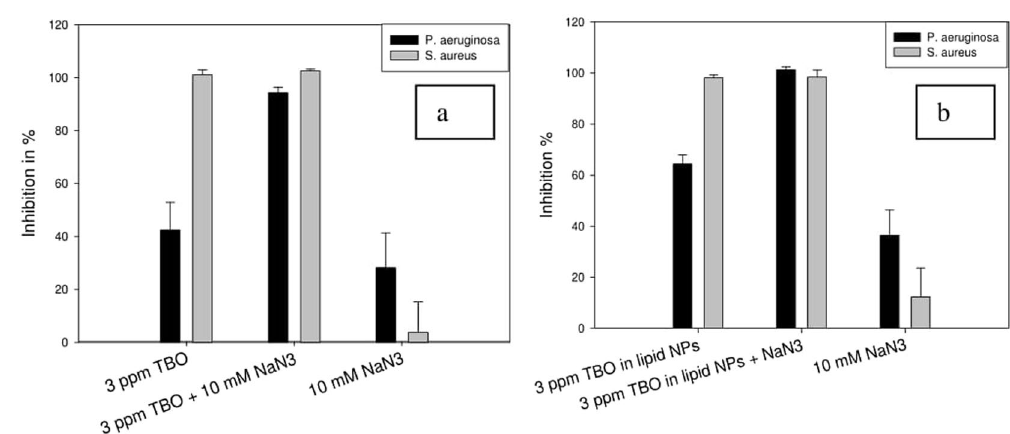
Figure 7. Effect of sodium azide combined with ( a ) TBO in water and ( b ) TBO in lipid nanoparticles on inhibition of P . aeruginosa and S . aureus - Inhibition increased in both the cases after combination with sodium